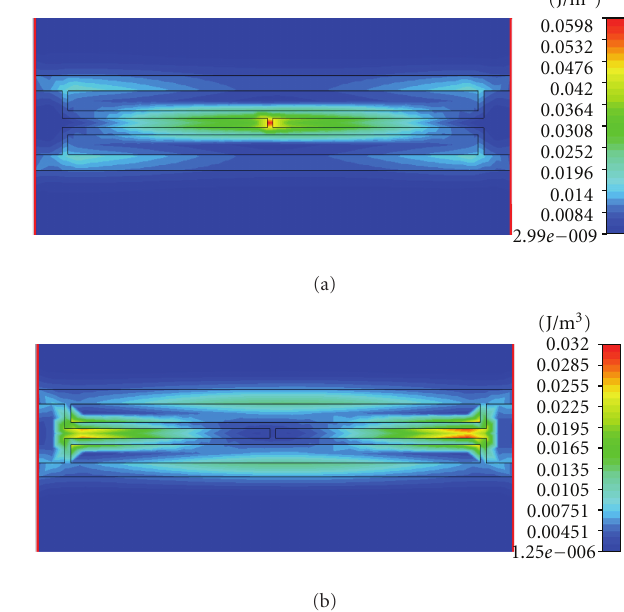
Figure 10: Setup for magnetic field computation, l 1 = l 2 = 0 . 45mm, g 1 = g 2 = 0 . 1 mm, and l = 7 . 24 mm.